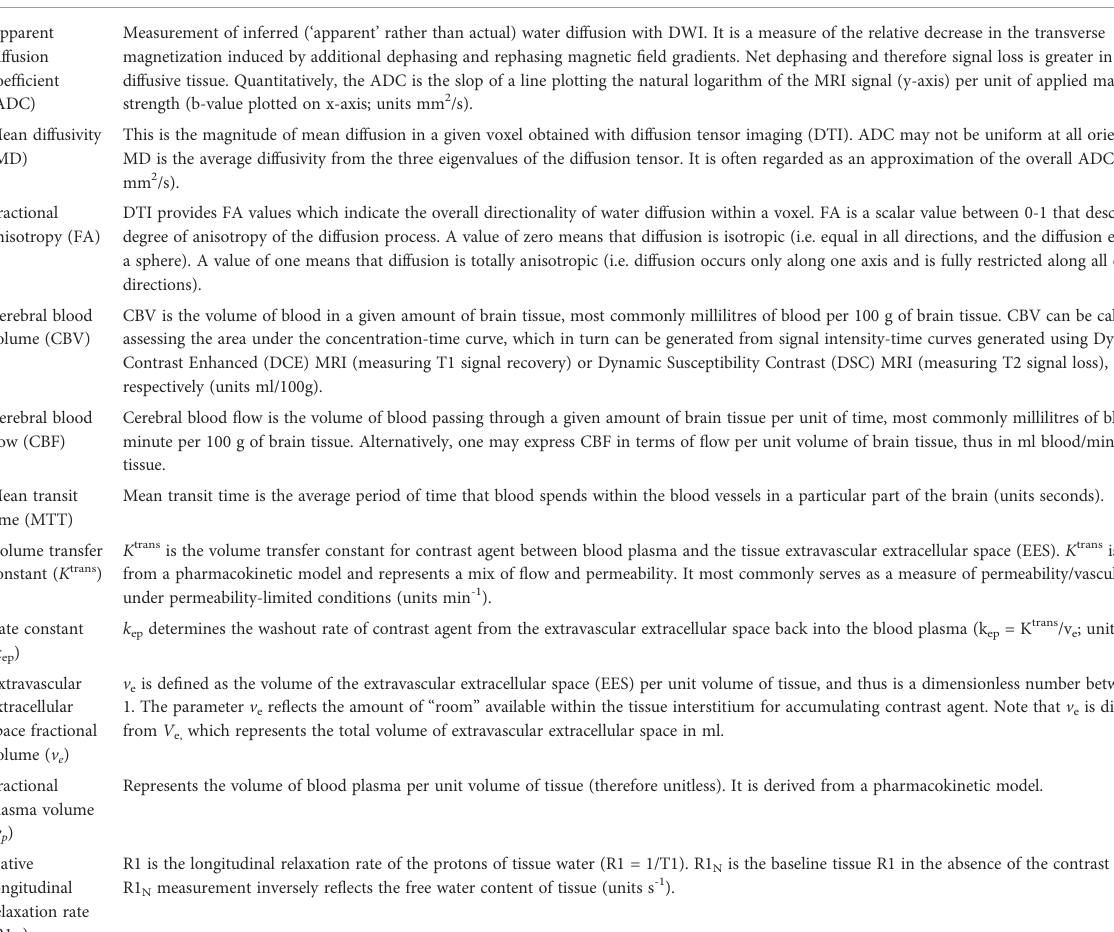
TABLE 1 Conventional imaging biomarkers in glioblastoma (12). Imaging